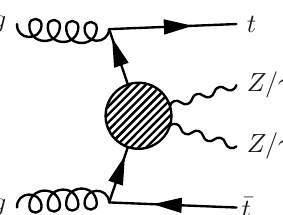
Figure 28. Schematic Feynman diagram for the EW-induced t (cid:22) t ( Z=(cid:13) )( Z=(cid:13) ) processes and their embeddings of the t Z t Z , t Z t (cid:13) and t (cid:13) t (cid:13) subamplitudes. ! ! ! Figure 29 con(cid:12)rms the lack of interfering energy growth in t (cid:22) tZZ for the majority